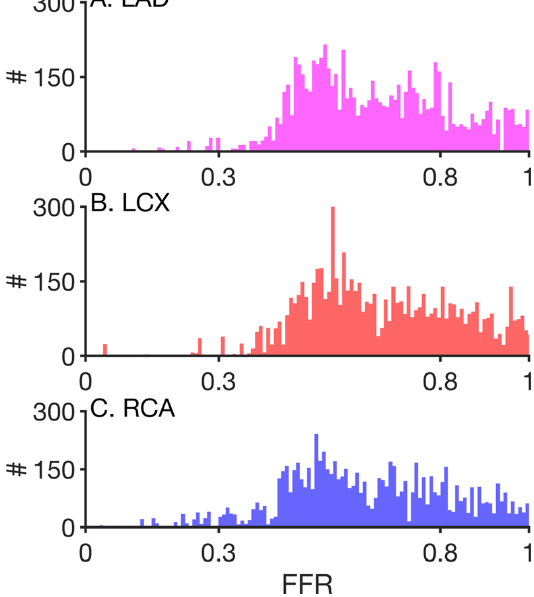
Figure 6. Histograms of FFR obtained from PRCC simulations (see Figure 7). Panel ( A ) shows the data for LAD, panel ( B ) for LCX, and panel ( C ) for RCA.